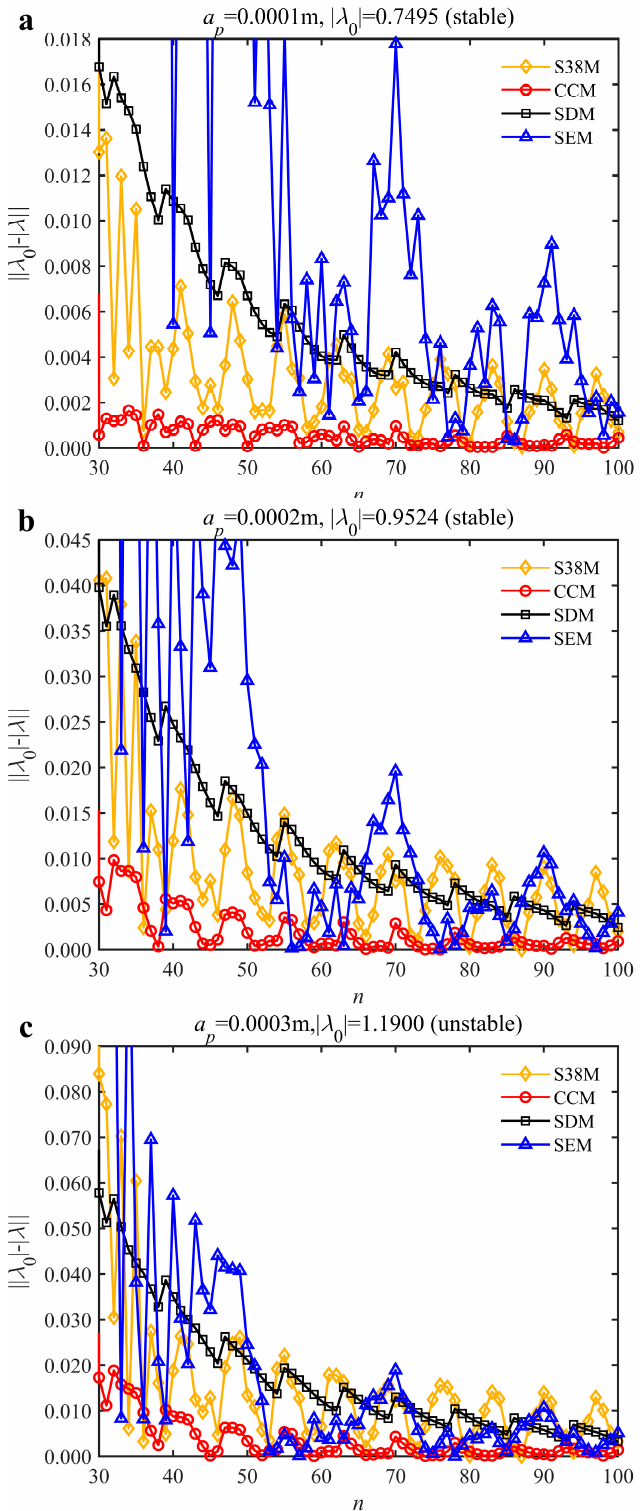
Figure 9. Convergence rate comparisons of the S38M, CCM, SDM, and SEM when and a / D =